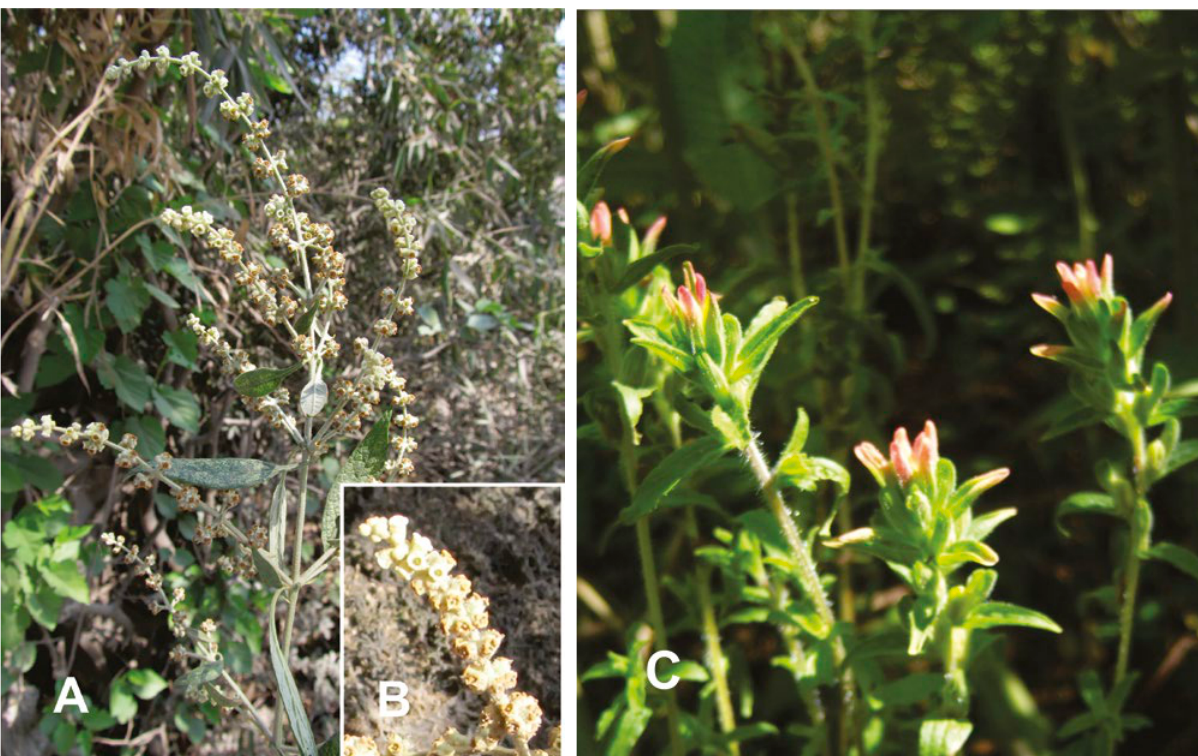
Figure 1. Morphological overview of the studied plants, A) General appearance of Buddleja iresinoides , and B) inflorescence detail; C) Gen- eral appearance of Castilleja arvensis